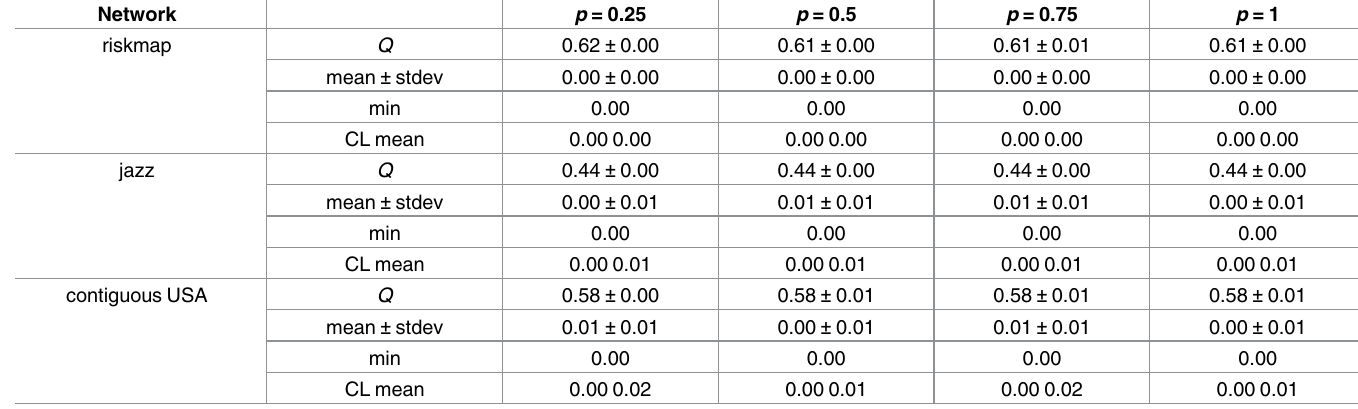
Table 2. Fraction of nodes that can improve their payoffs by unilateral deviation in solutions reported by p MNEO for real world networks